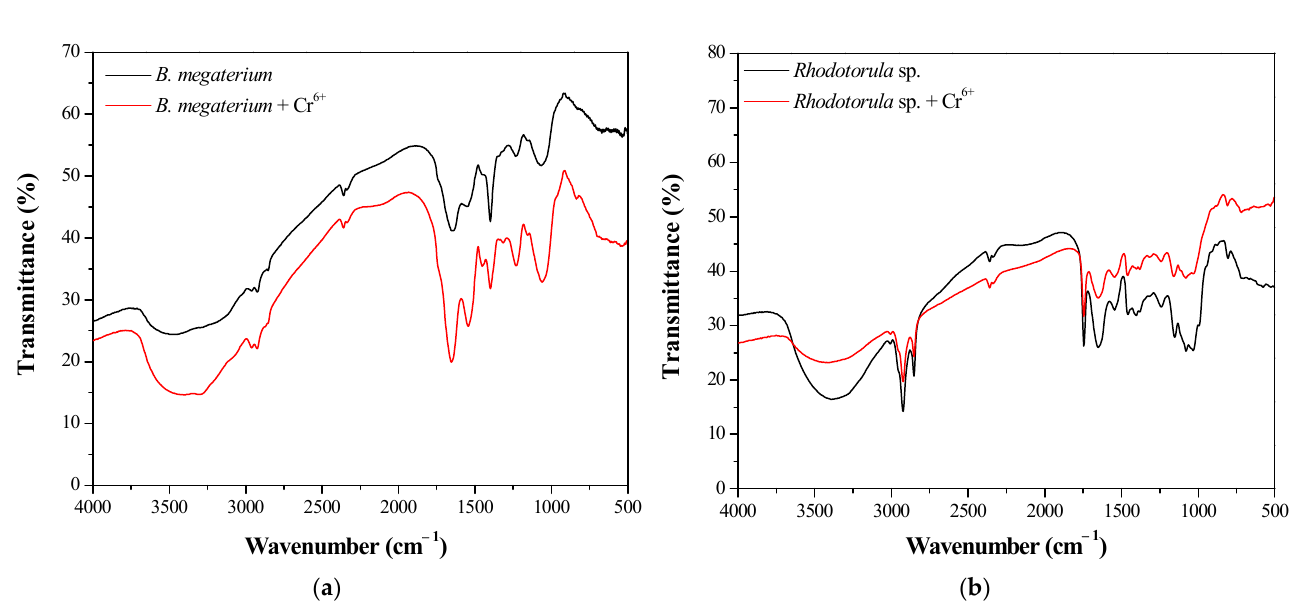
Figure 10. IR spectra recorded for ( a ) Bacillus megaterium and ( b ) Rhodotorula sp. before and after Cr 6+ biosorption.